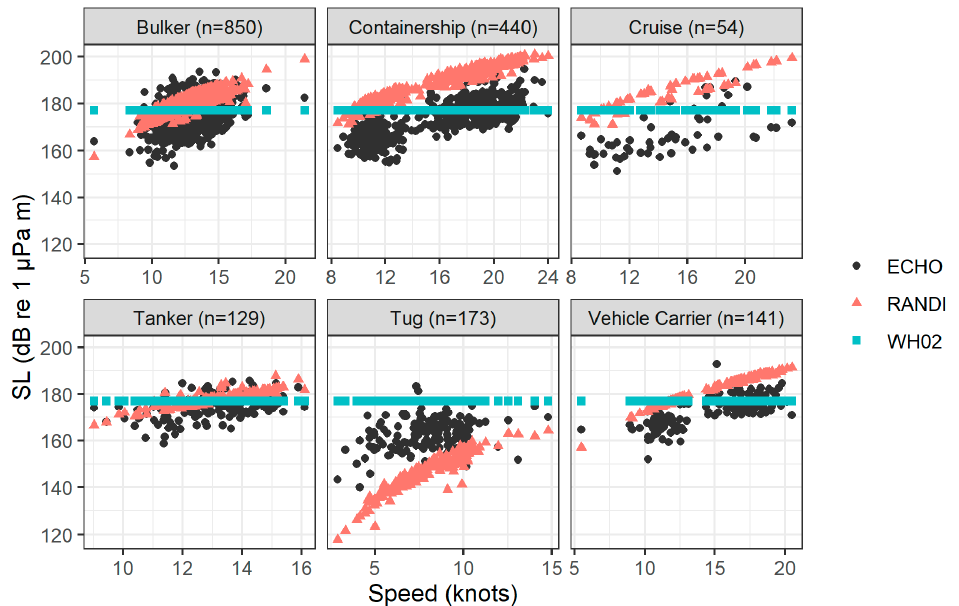
Figure 2. Scatter plots of predicted and observed (ECHO) source levels versus speed, in the 63 Hz decidecade band (one of the two MSFD indicator bands [2]), for the RANDI and WH02 models, for six vessel types. The n value in each panel indicates the number of measurements for the specified vessel type. Predictions of the WH02 model do not vary with vessel speed and length, whereas predictions of the RANDI model vary with vessel speed and length according to power law functions, see Equation (4).